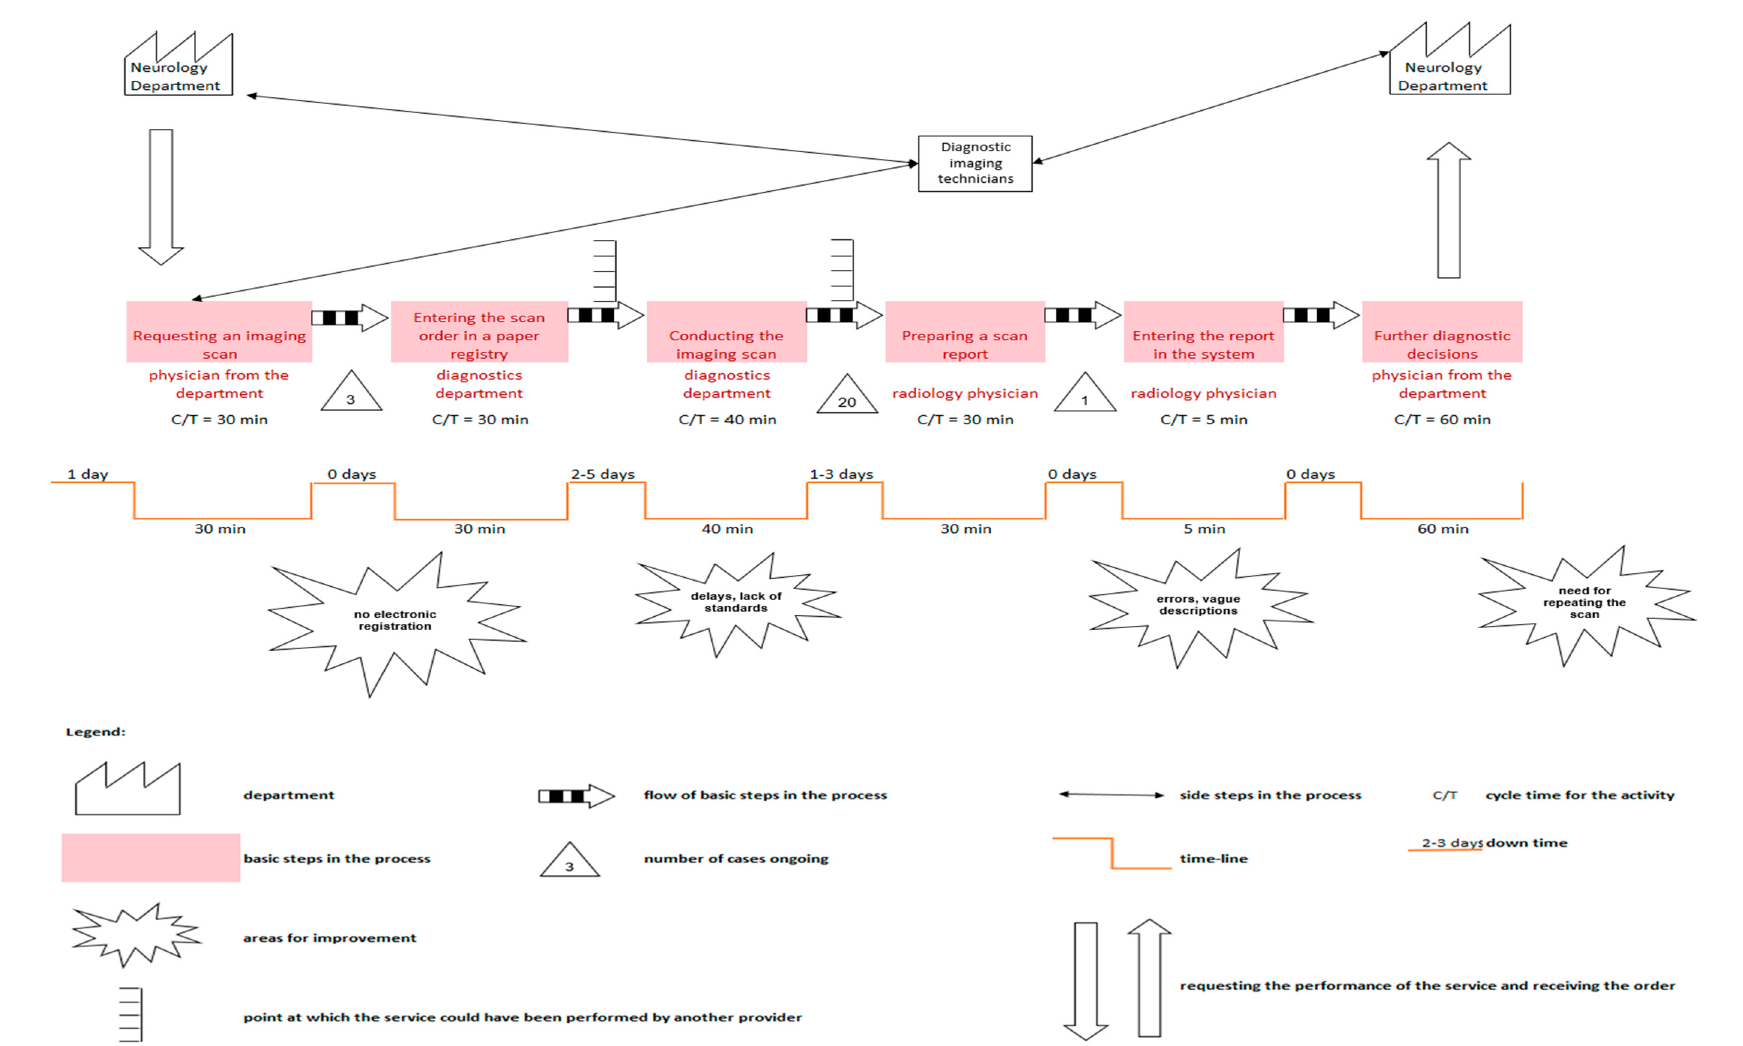
Figure 2. The map of the process of completing an imaging